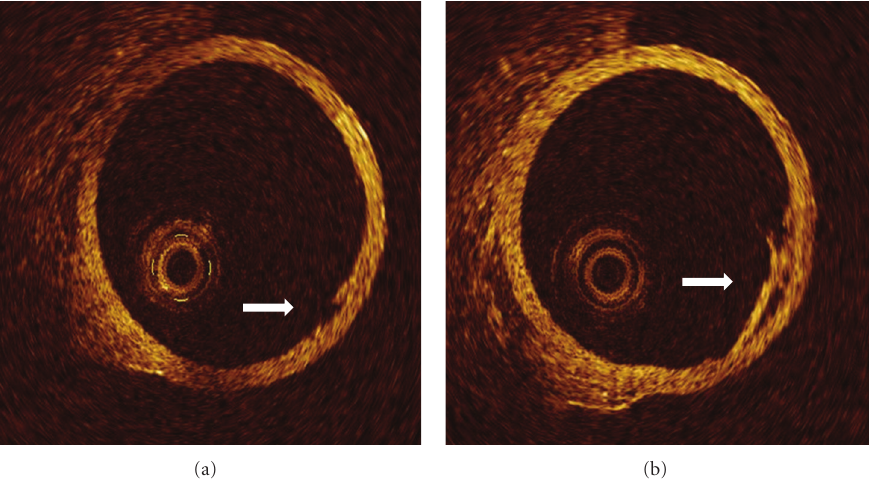
Figure 2: OCT images of acute vessel injury. (a) Mild vessel injury with punctated breaks in the IEL (arrow). (b) Severe vessel injury with disruption of the media